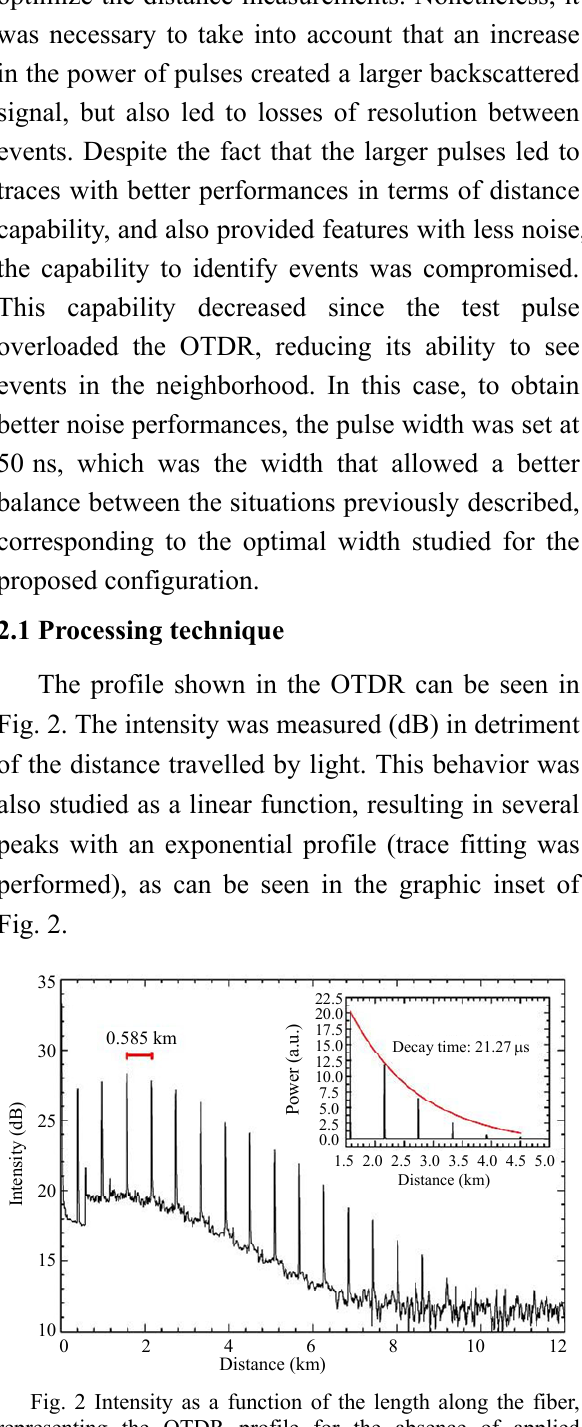
Fig. 3 Linear fits performed to the data varying with the applied